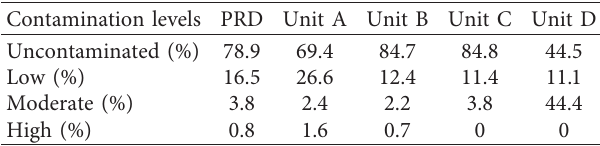
Table 1: Groundwater salinity contamination in various groundwater units in the Pearl River